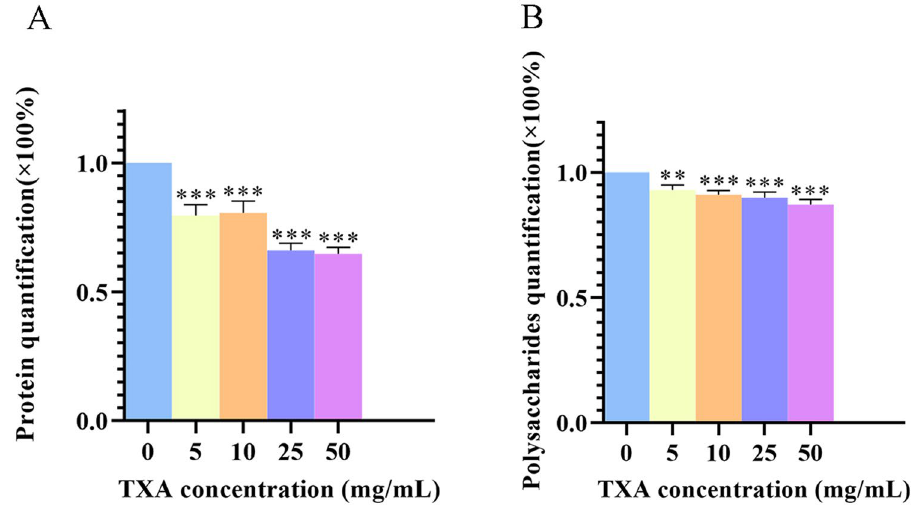
Figure 3. ( A ) Quantification of proteins and ( B ) polysaccharides in ATCC43300 biofilm matrices after culturing with TXA at different concentrations for 36 h. The results are presented as the mean of three independent experiments and were analysed by one-way ANOVA (* p < 0.05 indicates statistical